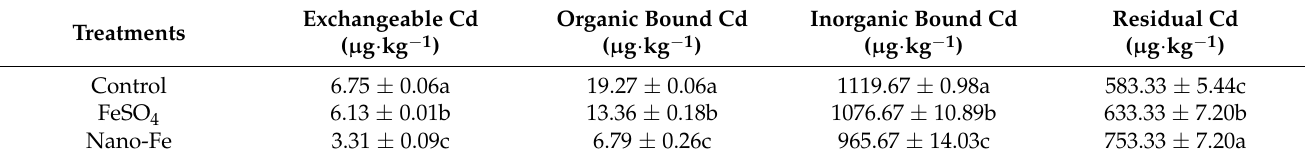
Table 2. Effect of exogenous Fe applied as FeSO 4 and Nano-Fe on the Cd contents in soil.